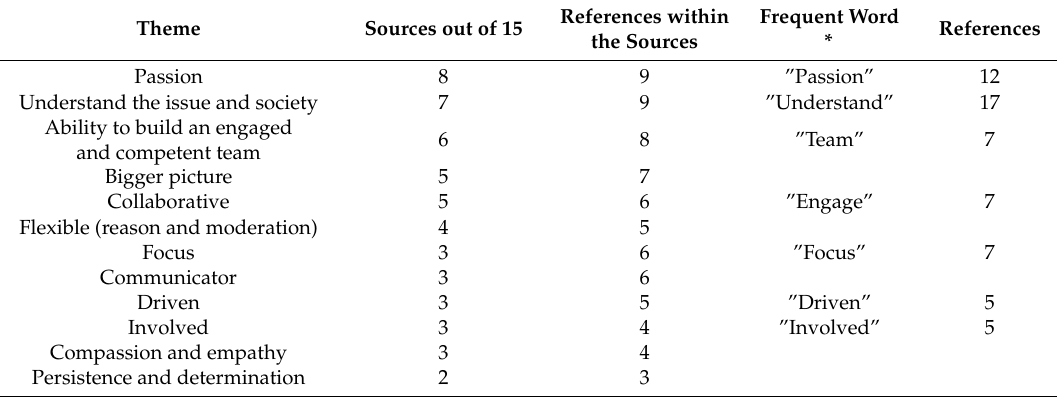
Table 2. Themes and words cited in relation to the question “What makes a good international animal welfare